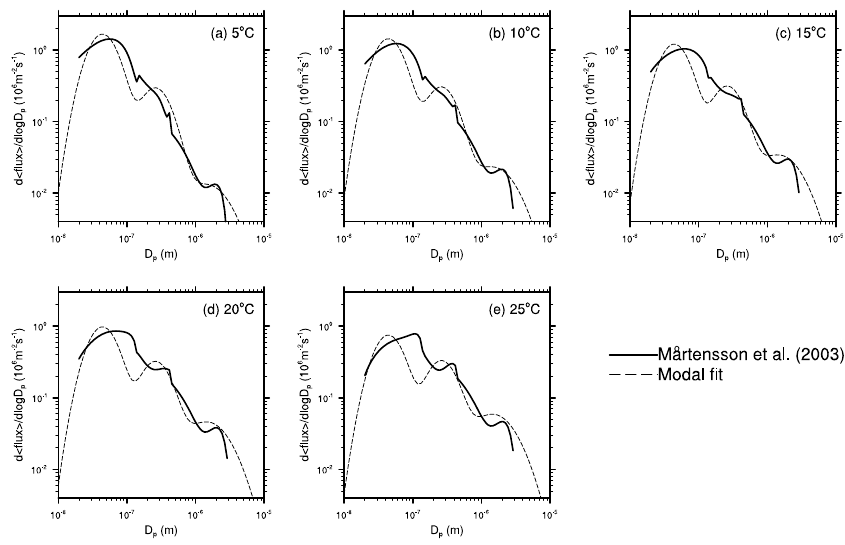
Fig. 2. Comparison of the temperature dependence of the size resolve sea salt aerosol flux from M˚artensson et al. (2003) (solid line) with the modal approximation used in CAM-Oslo (dashed line). Note: in all cases U 10 was assumed to be 9ms − 1